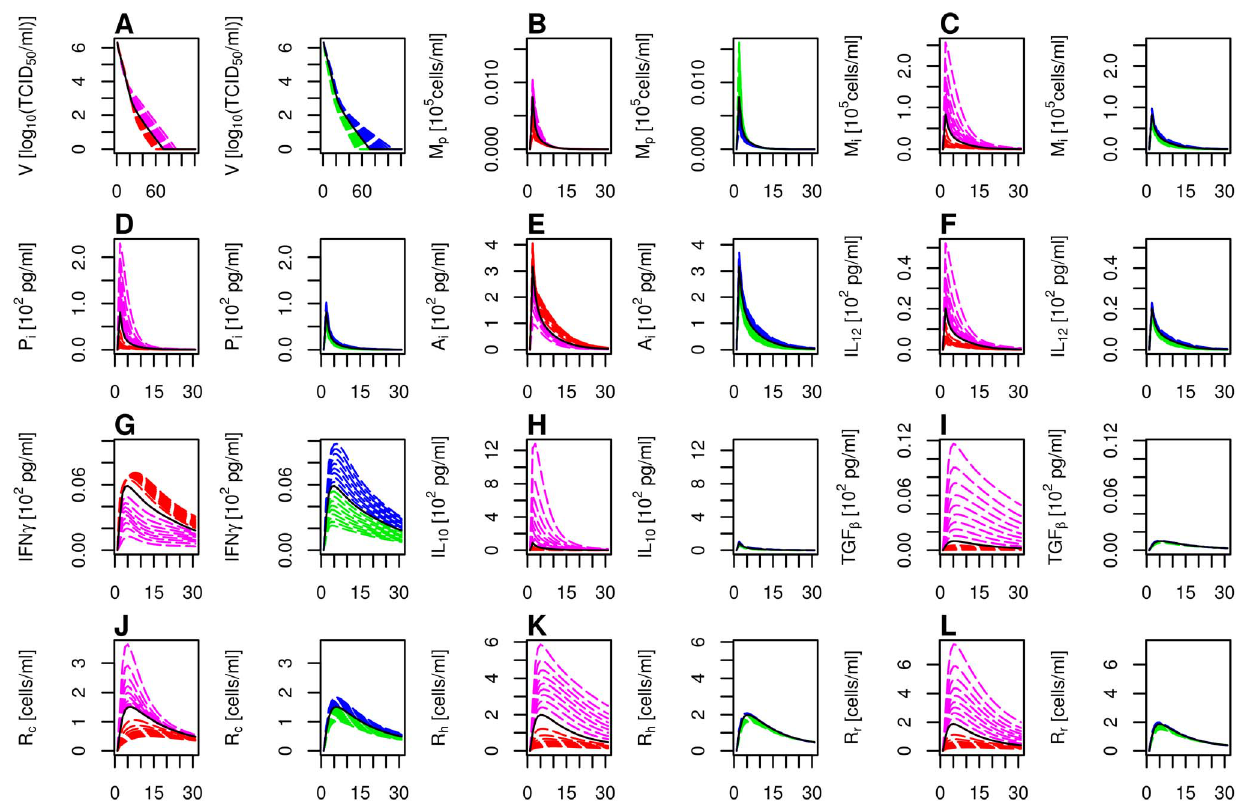
Figure 5. Immune and infection dynamics for variable host susceptibility and strain virulence. Evolution of twelve variables (panels A to L ) during the first 30 days of infection (unless specified). A : Viral titer ( V , during 120 days). B : Phagocyting macrophages ( M P ). C : Infected macrophages ( M I ~ M L z M E ). D : Pro-inflammatory cytokines ( P i ~ IL 1 b z IL 6 z IL 8 ). E : Innate antiviral cytokines ( A i ~ TNF a z IFN a ). F – I : Immuno- regulatory cytokines ( F : IL 12 , G : IFN c , H : IL 10 and I : TGF b ). J : Adaptive cellular effectors ( R c ). K : Adaptive humoral effectors ( R h ). L : Adaptive regulatory effectors ( R r ). For each variable, the left plot corresponds to scenarios SB ? SA, in which the antiviral cytokine synthesis is higher (S0 ? SB, red) or lower (S0 ? SA, magenta) than in the reference scenario (S0, black). The right plot corresponds to scenarios S1 ? S2, in which the macrophage permissiveness is lower (S0 ? S1, green) or higher (S0 ? S2, blue) than in the reference scenario (S0, black). Low susceptibility and virulence levels correspond to scenarios which promote the antiviral cytokine synthesis (red) and scenarios with low macrophage permissiveness (green). High susceptibility and virulence levels correspond to scenarios which promote the immuno-modulatory cytokine synthesis (magenta) and scenarios with high macrophage permissiveness (blue) Scenarios are defined in Table